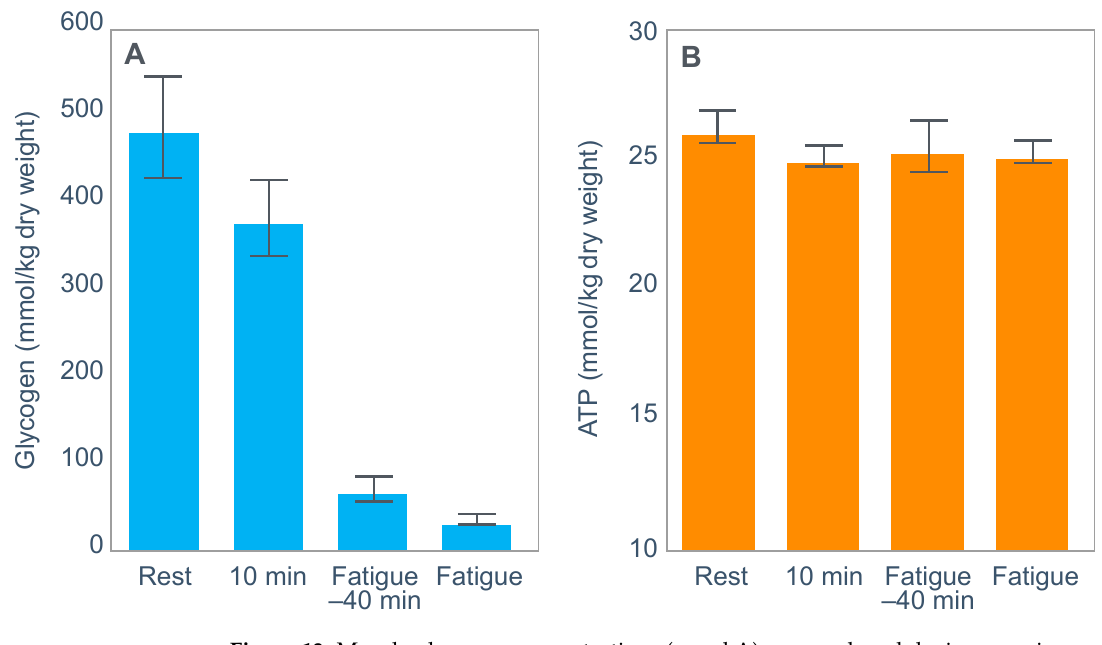
Figure 13. Muscle glycogen concentrations (panel A ) were reduced during exercise, reaching very low levels at fatigue. Yet muscle ATP concentrations (panel B ) remained at pre-exercise resting concentrations during exercise and at the point of fatigue. The total adenine nucleotide pool (TAN) was also not reduced at fatigue. Adapted with permission from ref. [99]. Copy-right Year 2003 American Physiological Society.